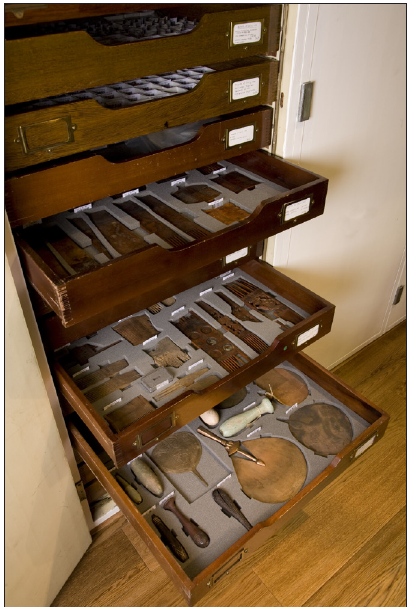
Figure 2: Petrie Museum storage